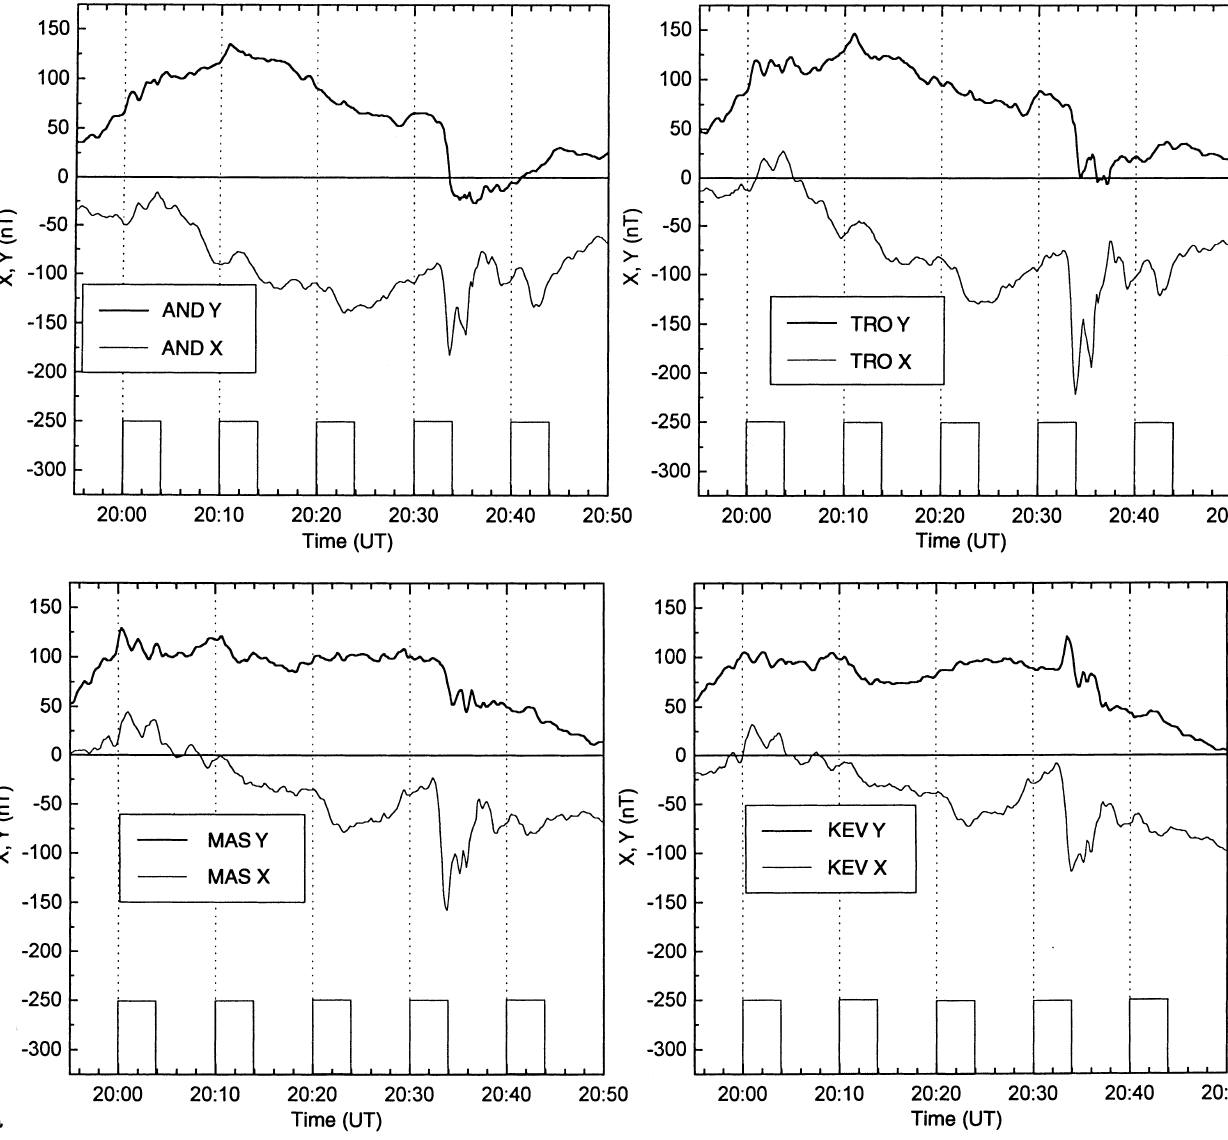
and b along the longitude from BJN to OUJ (see Fig. 1b). The intervals when the Tromsø heater was turned on are marked on the